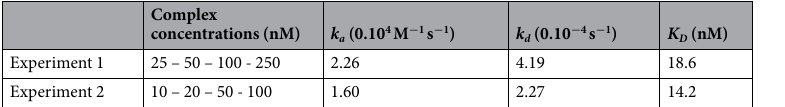
Table 1. Surface plasmon resonance data for direct binding of proMMP-2:TIMP-2 complex to immobilized megalin/LRP-2. The equilibrium constants of dissociation ( K D ) were calculated from the association ( k a ) and dissociation ( k d ) rate